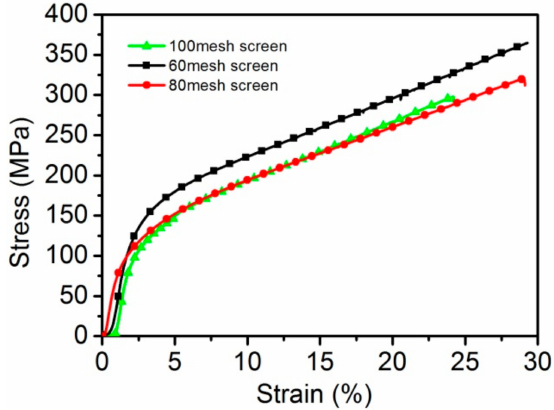
Figure 8. The uniaxial tensile stress-strain curves for the sintered wire mesh porous plates with different